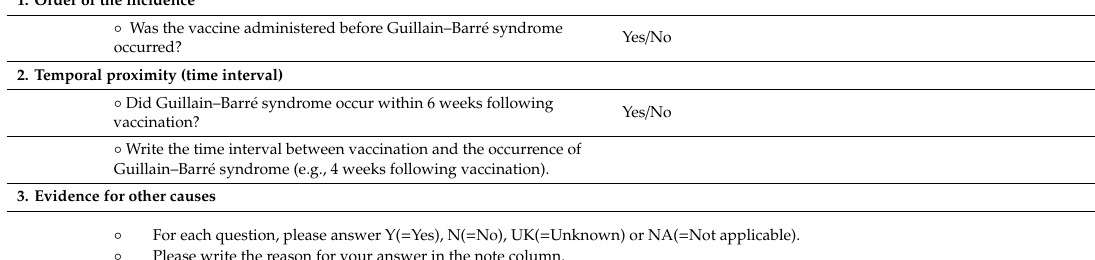
Table 2. Causality assessment guidelines for Guillain–Barr é syndrome following immunization: Checklist. 1. Order of the incidence ◦ Was the vaccine administered before Guillain–Barr é